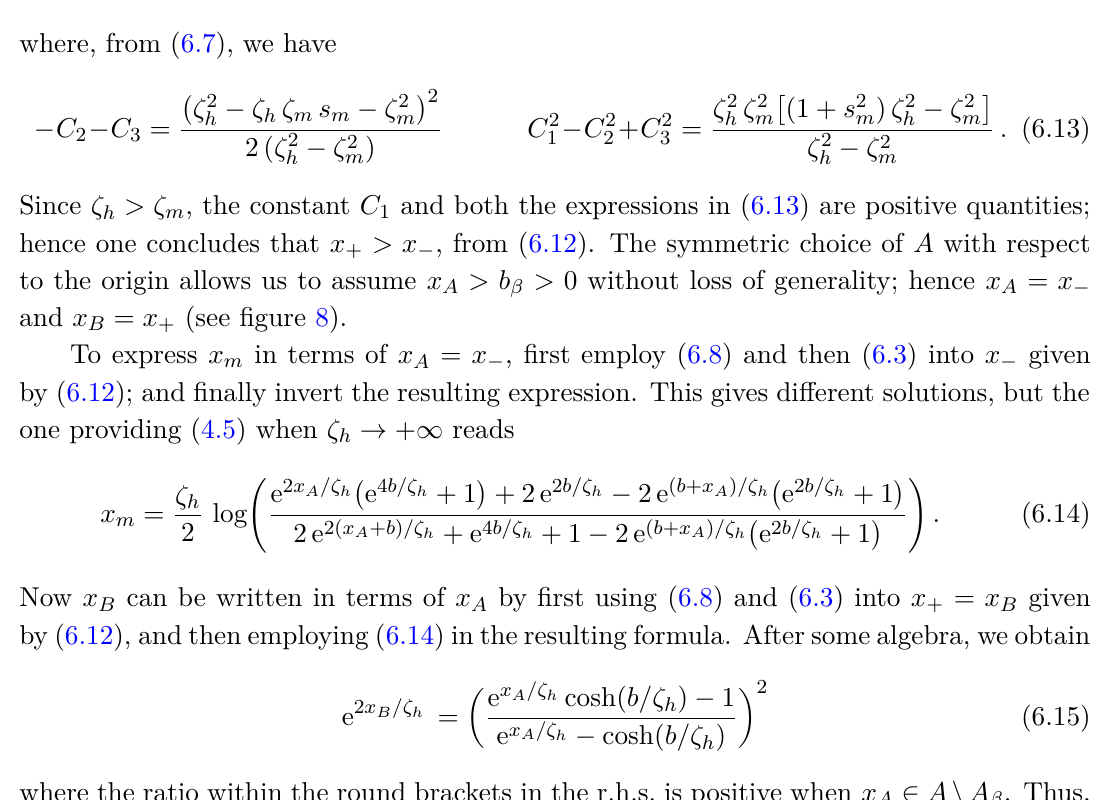
Figure 8 . Comparison between geodesic bit threads (green dashed curves) connecting a point x A ∈ A \ A β to a point x B ∈ B (see also figure 7) and the corresponding lines (starting at the same x A ’s) for the modular evolution in the Euclidean spacetime described in section 5.2 (black solid curves, see also figure